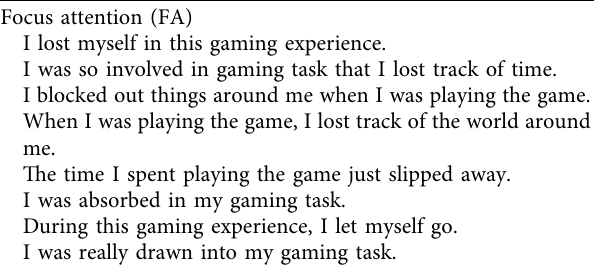
Table 2: Engagement questionnaire [50]. Items range from 1 to 7. Focus attention (FA)